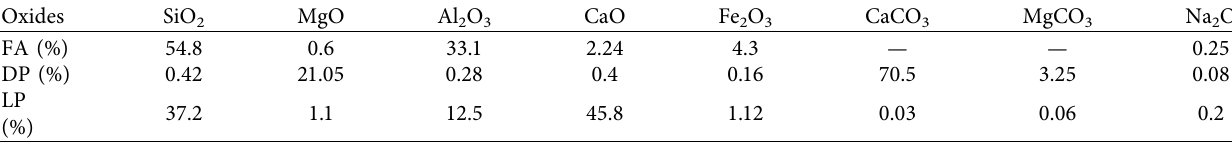
Table 4: Chemical compositions of considered FA, DP, and